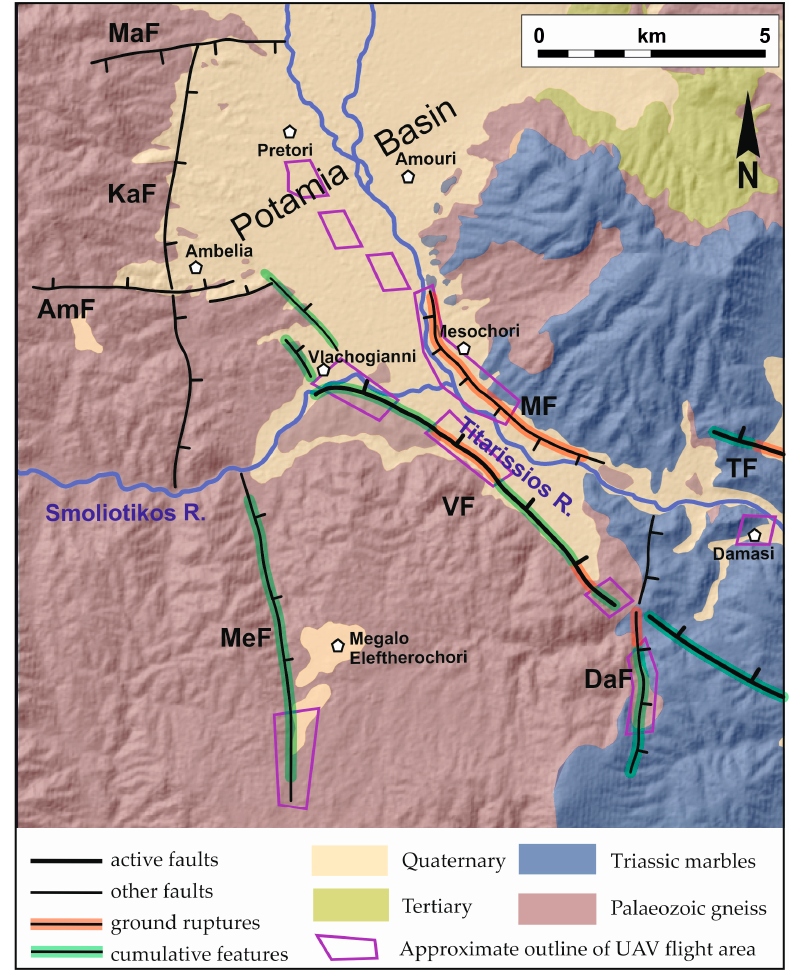
Figure 2. Geological map of epicentral area of Damasi earthquake showing main faults in epicentral area. Areas where detailed UAV field inspection took place are also shown.